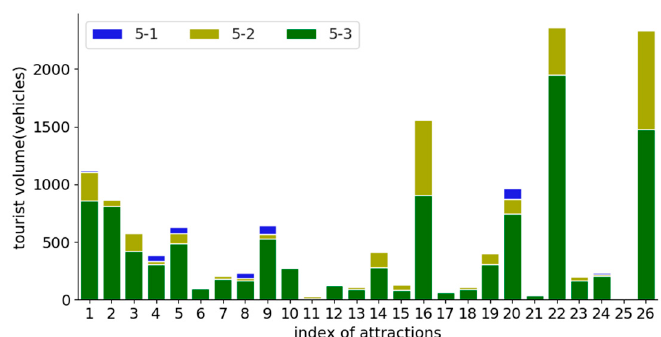
Figure 11. Tourist flow distribution for attractions in three days.